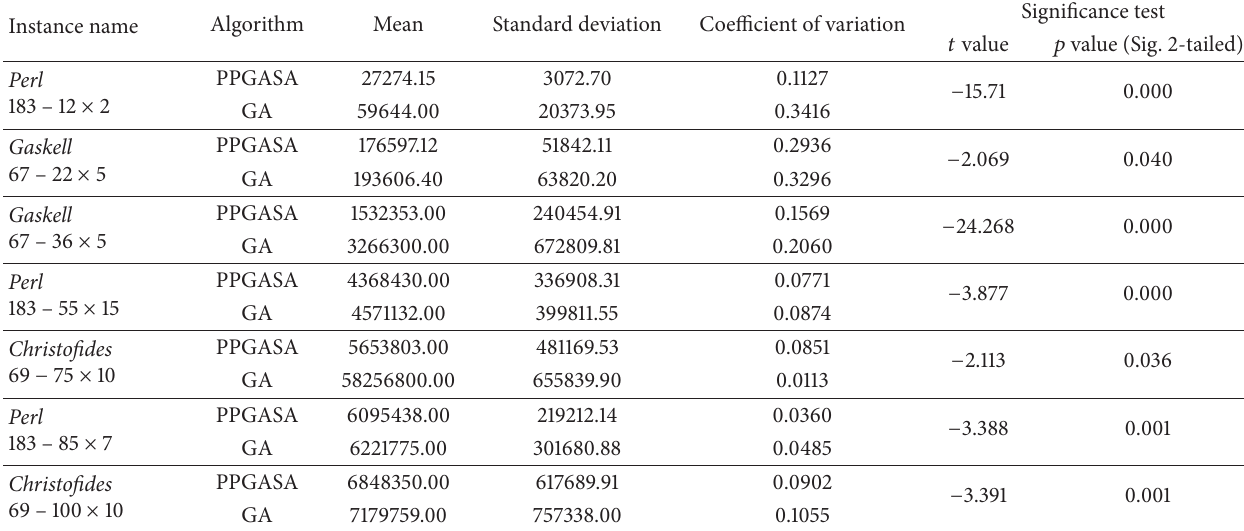
Table 8: Optimal objective function values of two algorithms (yuan).